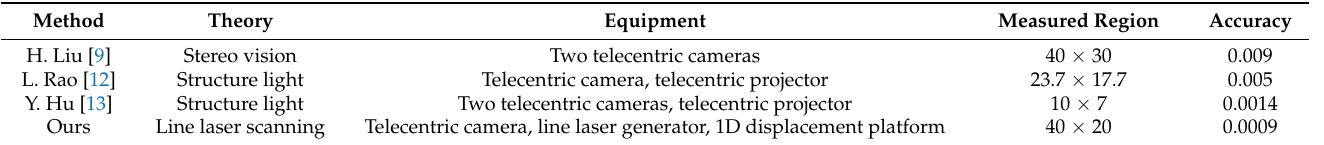
Table 3. Comparison with other methods (unit: mm).